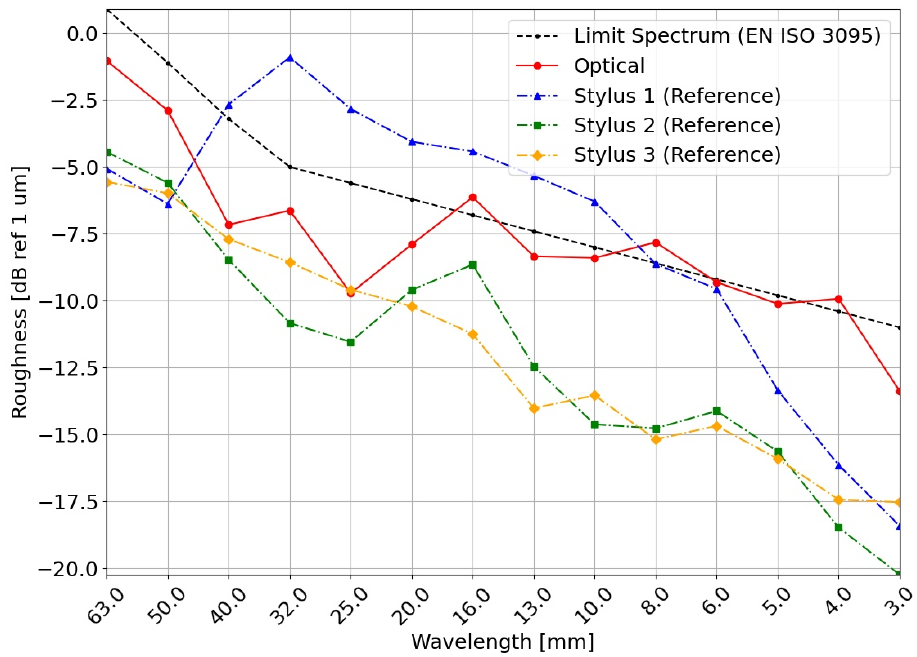
Figure A2. Spectrum of acoustic roughness for measurement of the optical system in the tunnel, compared with reference section A and the limit spectrum from EN ISO 3095 [22].